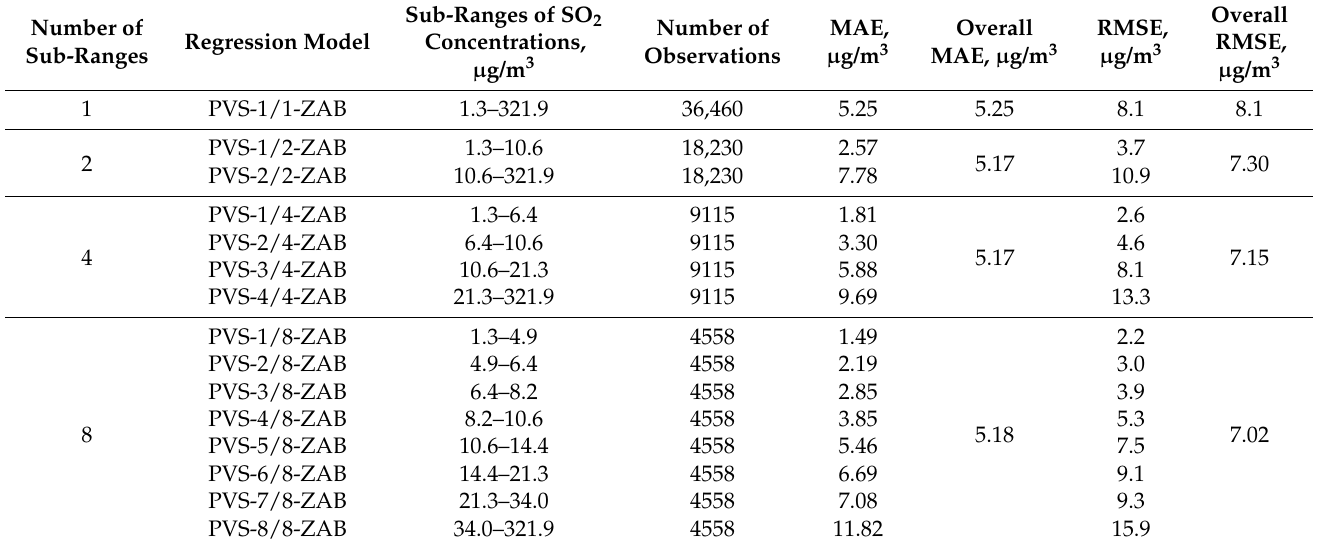
Table 15. Values of approximation errors of SO 2 concentrations in PVS models, Zabrze 2011–2016.